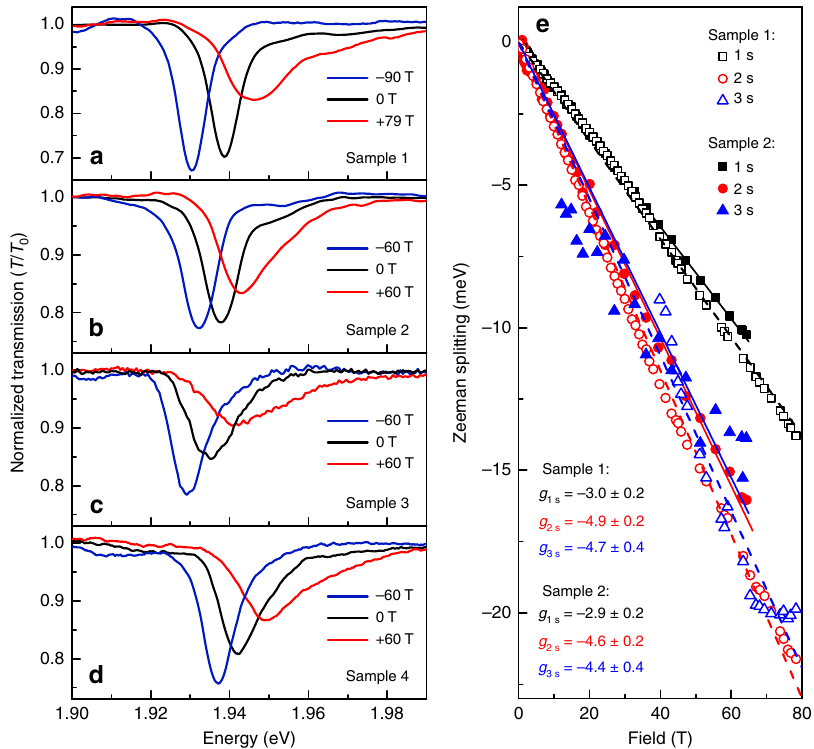
Fig. 3 Anomalous behavior of the 1 s exciton state in monolayer MoS 2 . a – d Normalized transmission spectra in the vicinity of the ground state (A:1 s ) exciton, in four different hBN-encapsulated monolayer MoS 2 structures. Black curves show spectra at B = 0 T, blue and red curves show the σ þ and σ (cid:4) spectra acquired at large negative and positive B , respectively. Note the fi eld-induced broadening of the higher energy Zeeman state in all cases. e The valley Zeeman splitting of the ns exciton states for samples 1 and 2; dashed lines show linear fi ts. The 1 s state exhibits an unexpectedly small valley Zeeman splitting in comparison with the excited Rydberg